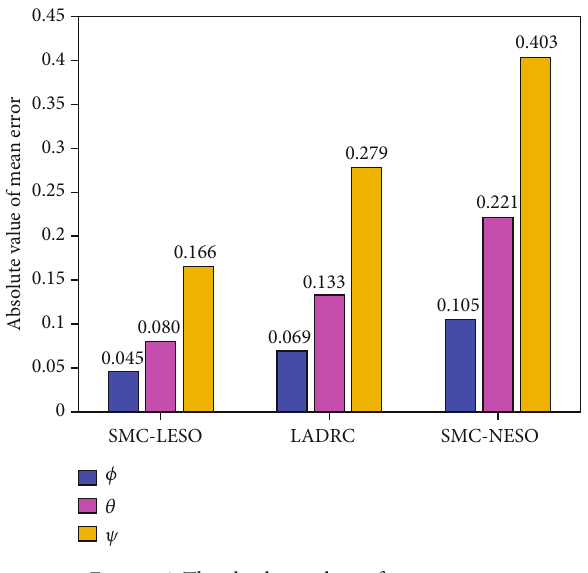
Figure 6: The absolute values of mean error.